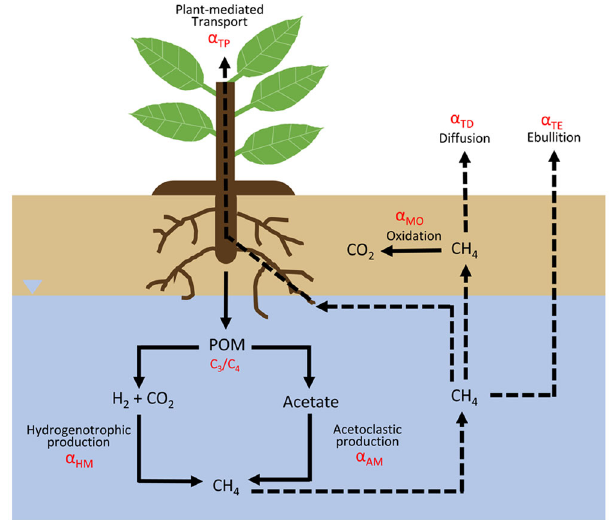
Fig. 1 Schematic diagram of wetland CH 4 dynamics and fractionations for isoTEM. The model simulates δ 13 C of precursor organic matter (POM) ( δ 13 C-POM), CH 4 production, oxidation, and transport to the surface. δ 13 C-POM is determined by global C 3 /C 4 plant distribution and long-term trends of atmospheric δ 13 C-CO 2 . CH 4 is produced by two pathways, one using H 2 and CO 2 and another using acetate, with fractionation factors ( α ) for HMs ( α HM ) ≈ 1.030 – 1.080 and for AMs ( α AM ) ≈ 1.000 – 1.040. Produced CH 4 is partly oxidized by methanotrophs with a fractionation factor α MO ≈ 1.015 – 1.035. Residual produced CH 4 is emitted to the surface via three processes, plant-mediated transport (TP), diffusion (TD), and ebullition (TE), with different fractionations, α ≈ 1.000 – 1.030, α ≈ 1.005, α ≈ 1.000, respectively (Supplementary TP TD TE Tables 2 – 4 and Method “ Model development, Model optimization ” ). Bold and dashed lines in the fi gure refer to chemical and transport processes,